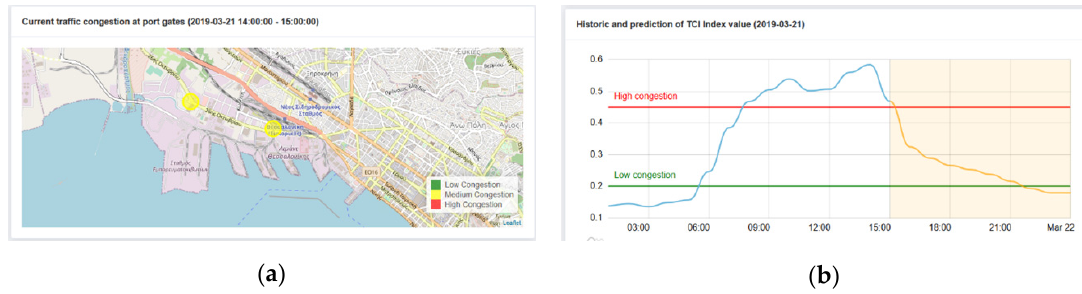
Figure 16. Configuration of thresholds: ( a ) for the representation of current status in a map; ( b ) for visualizing margins of TCI evolution and prediction.